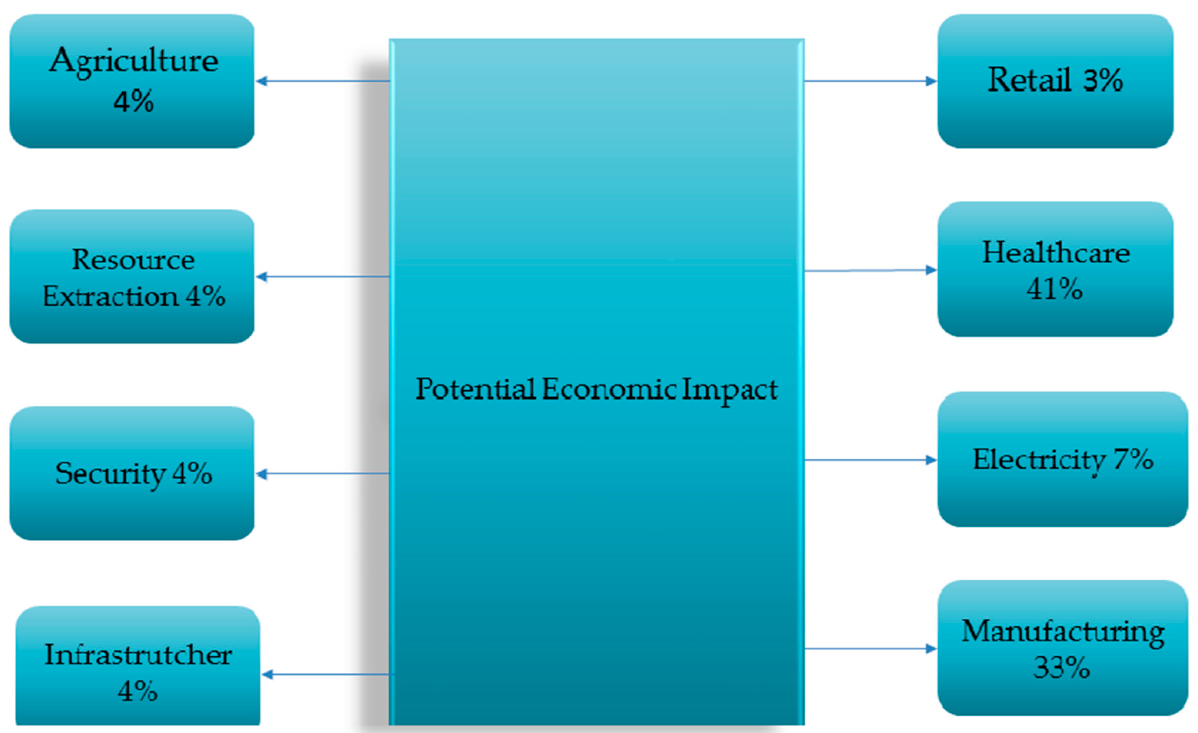
Figure 4. Potential economic impact of dominant IoT applications by 2025 [26]. Table 2. IoT key